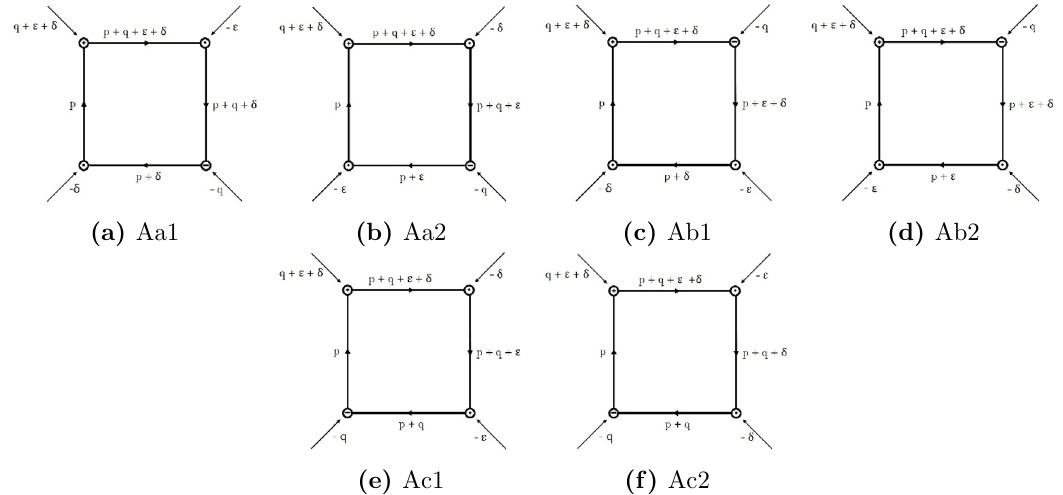
Figure 2. The box diagrams that contribute to h J + ( q + (cid:15) + (cid:14) ) J (cid:0) ( (cid:0) q ) J 0 ( (cid:0) (cid:15) ) J 0 ( (cid:0) (cid:14) ) i . All vertices 1 1 and propagators stand for their exact (all orders in (cid:21) ) versions. The vertices are labelled thus | (cid:8) for J + , (cid:9) for J (cid:0) , and (cid:12) for J 0 . The ‘A’ in the name stands for the fact that these are box diagrams. 1 1 The second letter denotes the position of the vector vertices (a/b/c for non-adjacent/adjacent horizontal/adjacent vertical) and changing the number at the end switches the two scalar vertices ( (cid:15) ! (cid:14)